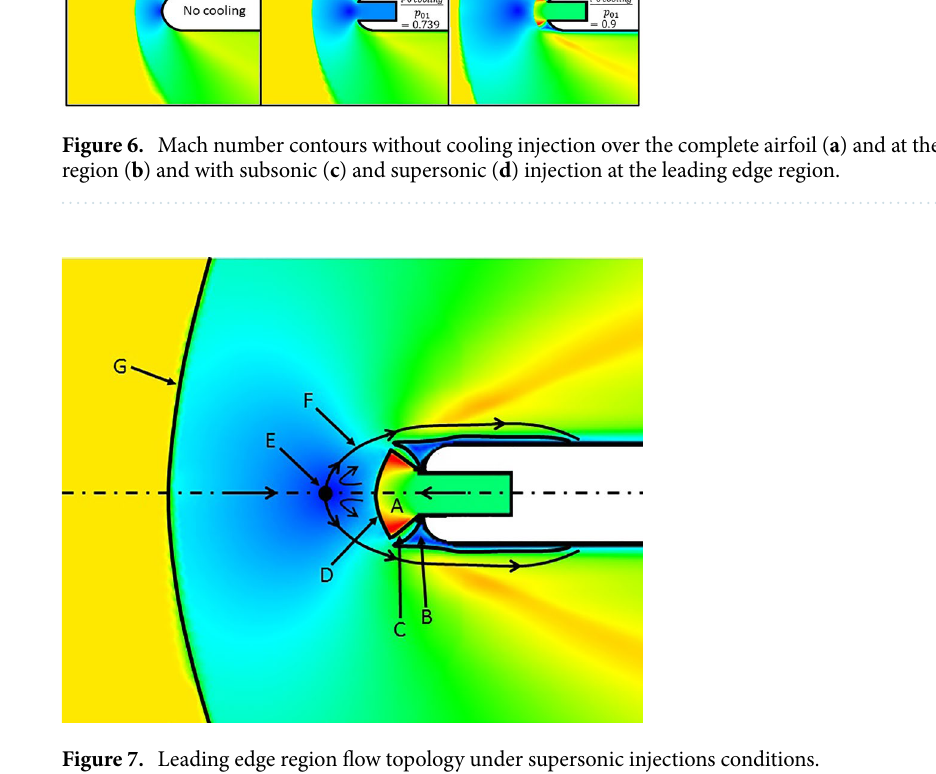
Figure 7. Leading edge region flow topology under supersonic injections